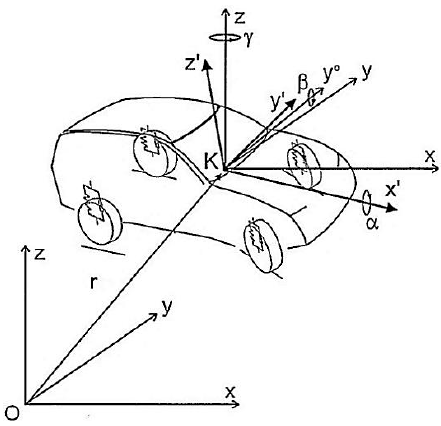
Figure 4. Model of vehicle with co-ordinate systems [11].